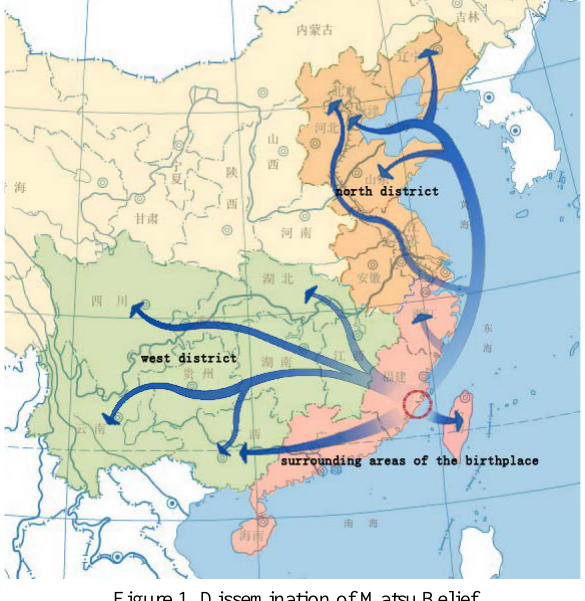
Figure 1. Dissemination of Matsu Belief The spreading of Matsu belief reflects the socia-economic exchanges and the population migration in history, while